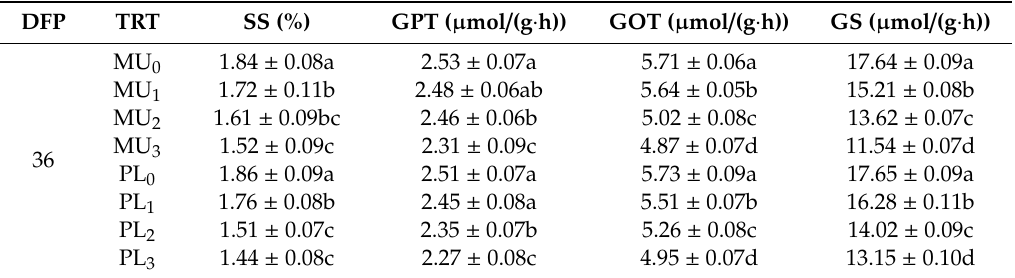
Table 3. The content of soluble saccharide and the activity of nitrogen invertase in rice roots under di ff erent straw incorporation